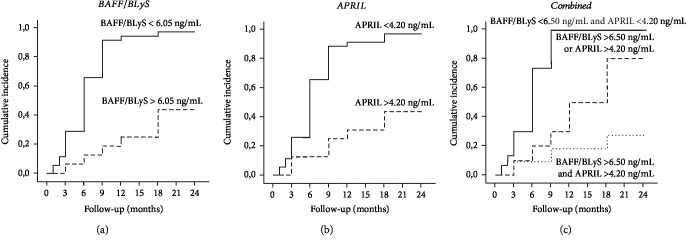
Cumulative incidence of complete/partial remission after immunosuppressive therapy among patients stratified for BAFF and APRIL serum levels. (a) Anti-PLA2R-positive PMN patients with BAFF/BLyS < 6.05 ng/mL at the time of renal biopsy achieved the composite endpoint with a significantly higher percentage, as compared with the patients with BAFF/BLyS above the cut-off (97.1% vs. 43.7%, log-rank test, p < 0.001). (b) Anti-PLA2R-positive PMN patients with APRIL < 4.20 ng/mL at the time of renal biopsy achieved the composite endpoint with a significantly higher percentage, as compared with the patients with APRIL above the cut-off (94.4% vs. 46.7%, log-rank test, p < 0.001). (c) If the entire study cohort was assigned to three groups depending on both cytokine baseline serum levels, patients with both BAFF/BLyS and APRIL below the cut-off (continuous line) showed a significantly higher complete or partial remission rate as compared with patients with only one cytokine above the cut-off (dashed line) or with patients with both cytokines above the cut-off (dotted line) (100% vs. 80.% vs. 17.3%, Kaplan-Meier lifetime analysis and log-rank test, p < 0.001).